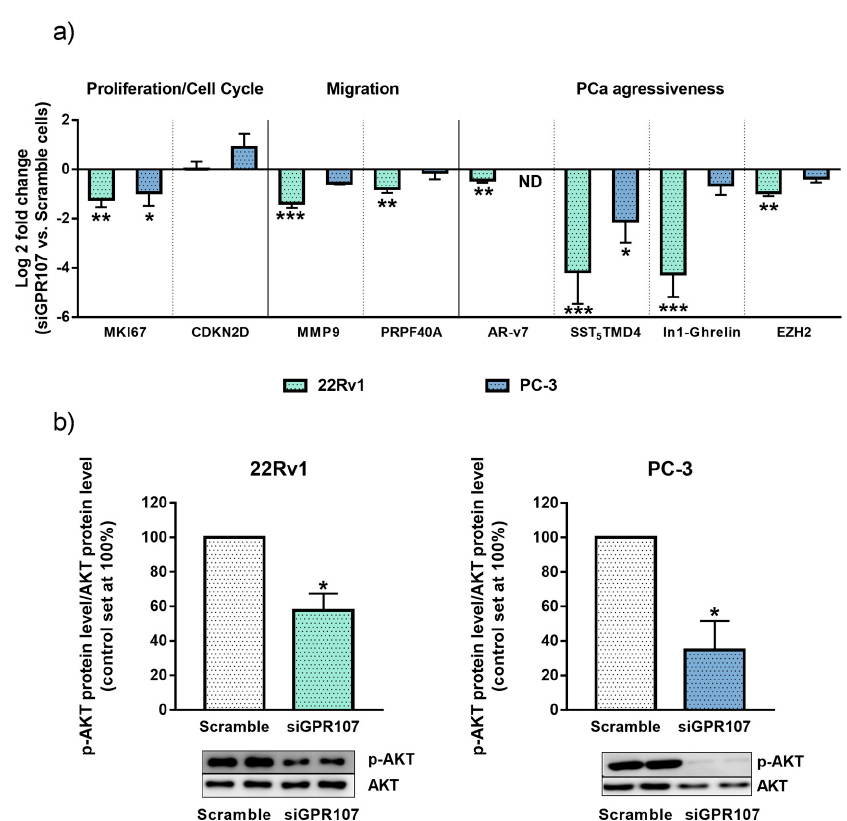
Figure 4. Molecular consequences of G protein-coupled receptor 107 (GPR107)-silencing in androgen-independent Prostate cancer (PCa) cells. ( a ) Fold change of markers of proliferation (Marked of Proliferation Ki-67 (MKI67)), cell cycle inhibition (Cyclin Dependent Kinase Inhibitor 2D (CDKN2D)), migration (Matrix Metallopeptidase 9 and Pre-MRNA Processing Factor 40 Homolog A (MMP9 and PRPF40A, respectively)) and aggressiveness (Androgen Receptor variant 7 (AR-v7), Somatostatin Receptor 5 Transmembrane Domain 4 variant (SST 5 TMD4), Intron 1-retained ghrelin variant (In1-Ghrelin) and Enhancer Of Zeste Homolog 2 (EZH2)) in androgen-independent cells (22Rv1 and PC-3) in response to GPR107-silencing compared to scrambled cells. Messenger RNA (mRNA) levels were determined by quantitative Polymerase Chain Reaction (qPCR), adjusted by Actin Beta (ACTB) expression levels and represented as log 2 of fold change of expression levels small interferent RNA(siRNA)-treated / scrambled-cells). ( b) Protein levels of phospho-AKT (p-AKT) in response of GPR107-silencing in androgen-independent PCa cells (22Rv1 and PC-3). p-AKT levels were normalized by total AKT protein levels. Protein data were represented as percent of scrambled cells (set at 100%). Asterisks (* p < 0.05; ** p < 0.01 and *** p < 0.001) indicate statistically significant di ff erences between GPR107-silencing and scrambled cells. siGPR107: small interferent RNA against